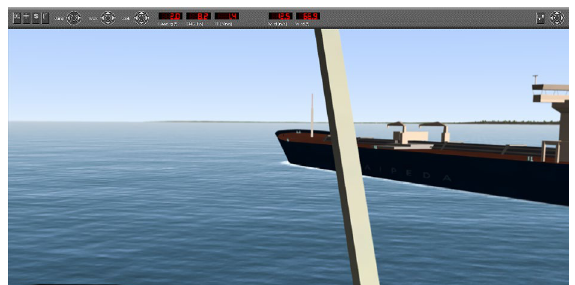
Fig. 14. Scheme for the PANAMAX tanker and a ferry sailing in parallel directions at a very short distance between the ships (wind direction perpendicular to the courses of the ships, velocity 12